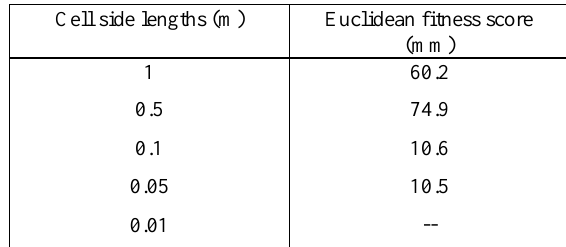
Table 3. NDT precision with different cell sizes